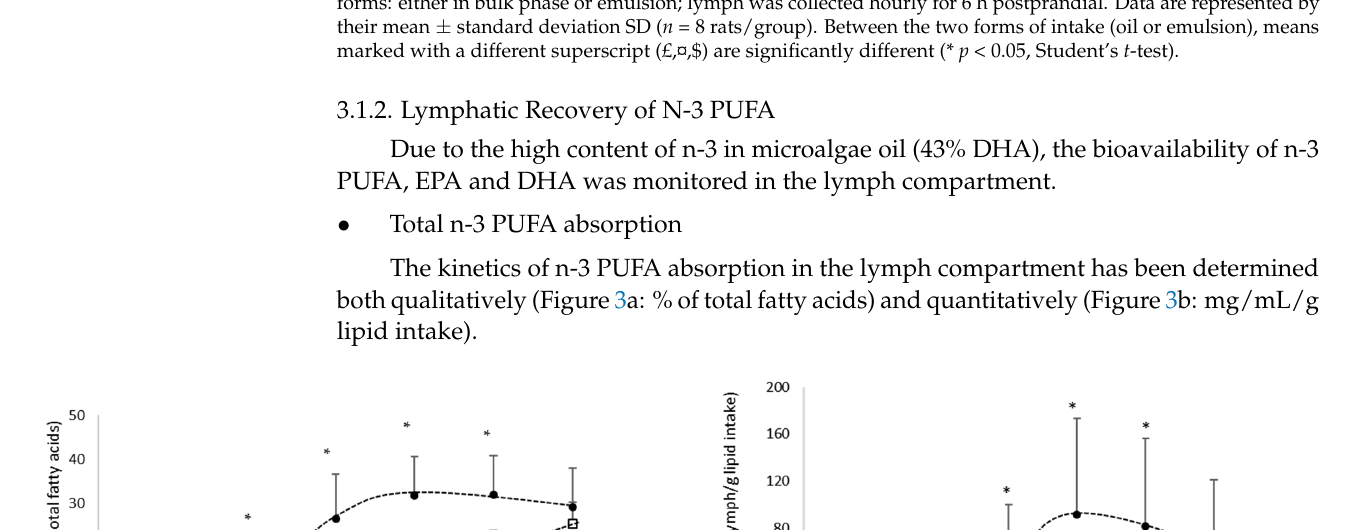
FA: fatty acid, PUFA: polyunsaturated fatty acid from n-6 and n-3 series, EPA: eicosapentaenoic acid, DHA: docosahexaenoic acid. AUC: area under the curve (mg/mL.h), Cmax: maximal concentration (mg/mL)